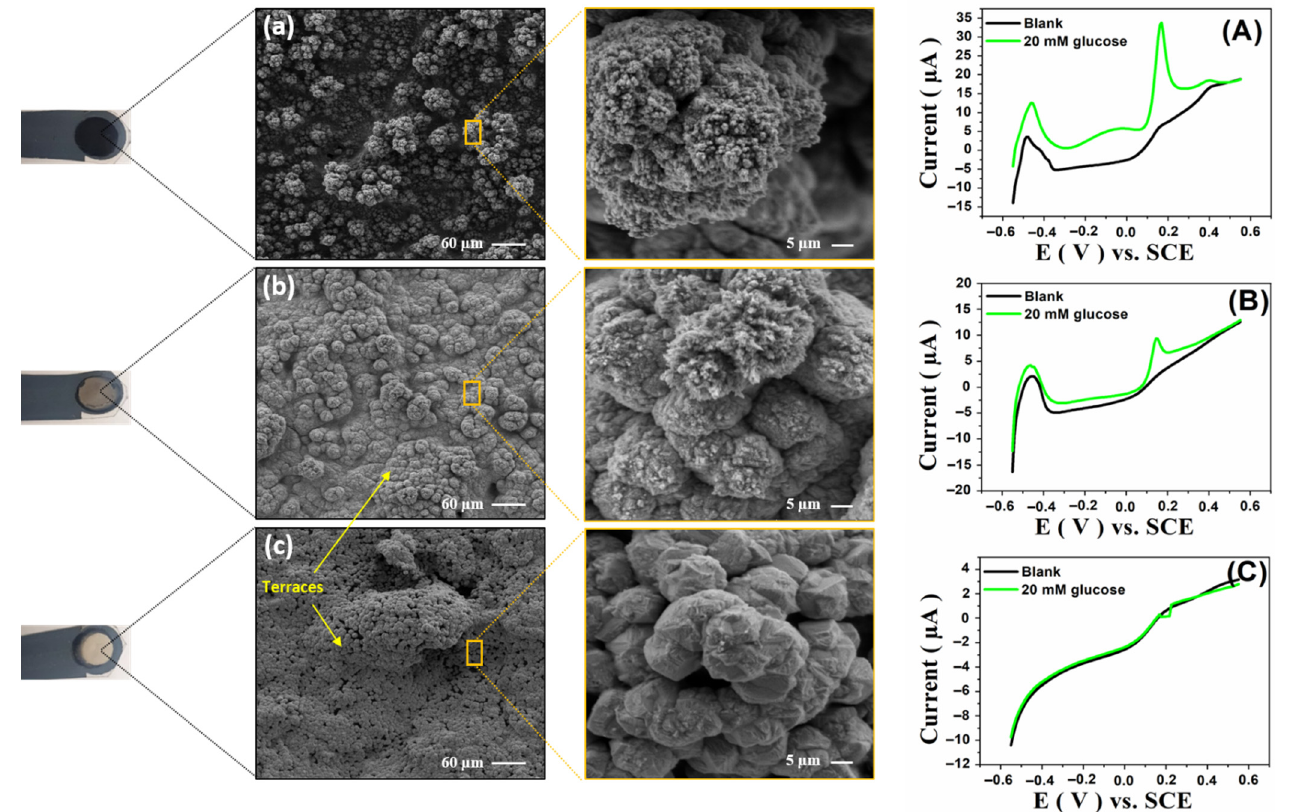
Figure 3. LSVs recorded in 0.1 M PBS (pH 7.4) without ( black line ) and with 20 mM of glucose ( green line ) with PdNS/f-CNT/SPCE after Pd electrodeposition at a fixed potential of − 0.2 ( A ), 0.0 V ( B ), and +0.4 V ( C ) vs. SCE for 300 s , scan rate 10 mV s − 1 . SEM images: evolution of the paladium structure shape from terrace-like to cauliflower-like Pd structures as a function of the electrodepo- sition potential: ( a ) − 0.2 V, ( b ) 0.0 V, and ( c ) +0.4 V vs. SCE.